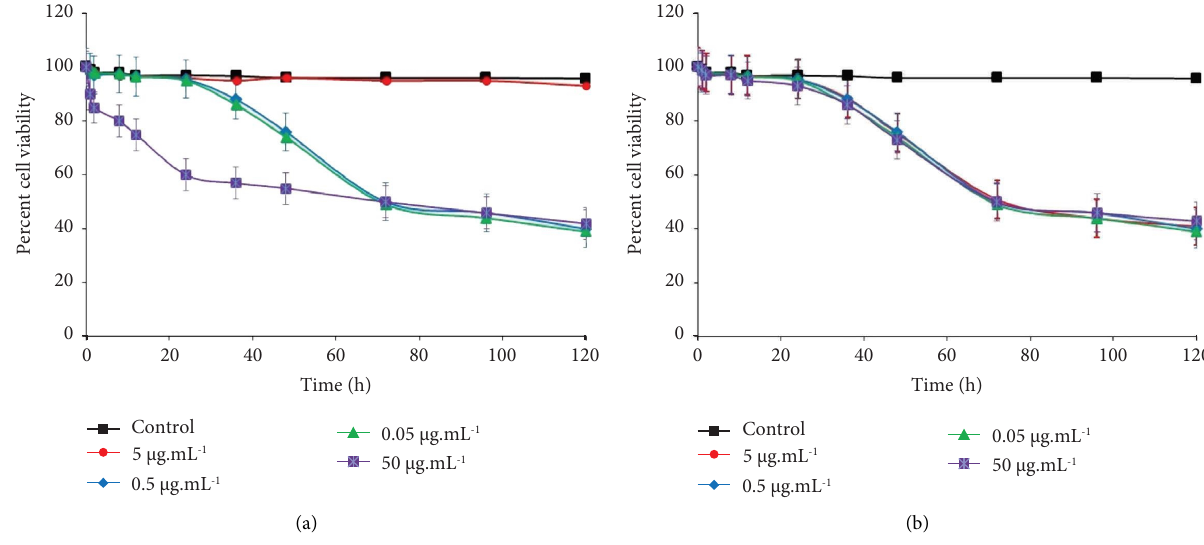
Figure 6: Viability of FU-PLGA-NPs produced with (a) RRG502 and (b) RRG755 copolymers following treatment with NCI-H69 cells. Te 96-well plates containing cell seeds were used to treat the cells for 24, 48, 72, 96, and 120hours with varied dosages of both formulations. Cell viability was assessed using the MTT test, and the outcomes were reported as a percentage of control wells (cells without treatment). Te mean and standard deviation are depicted in this fgure as the results of at least three independent tests that were performed in